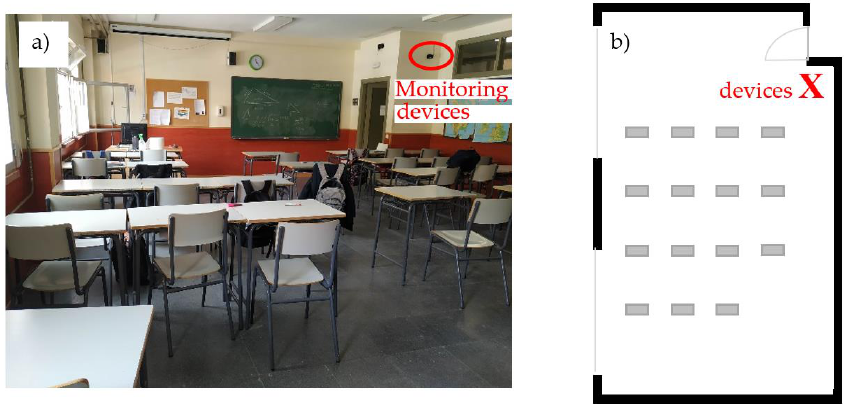
Figure 2. Overview selected classroom ( a ) real image and ( b ) schema of the monitoring.